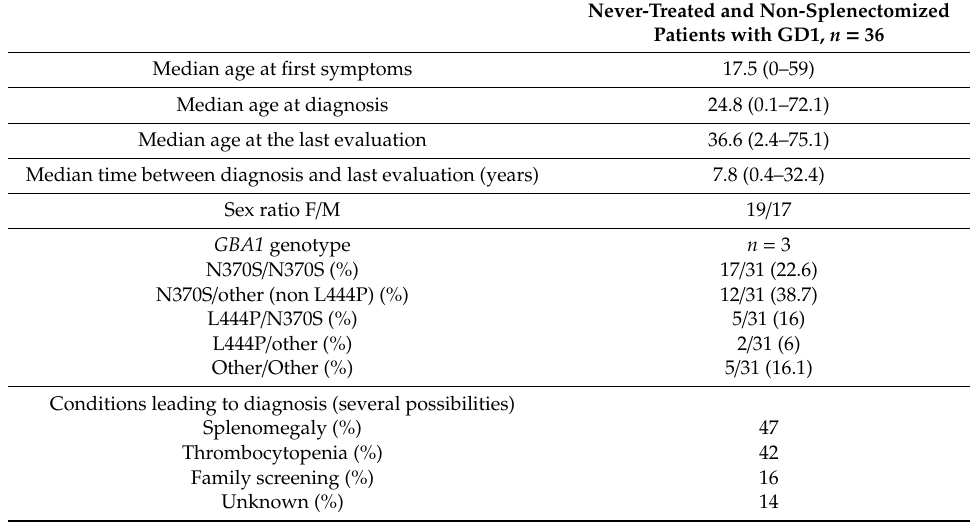
Table 1. Patients’